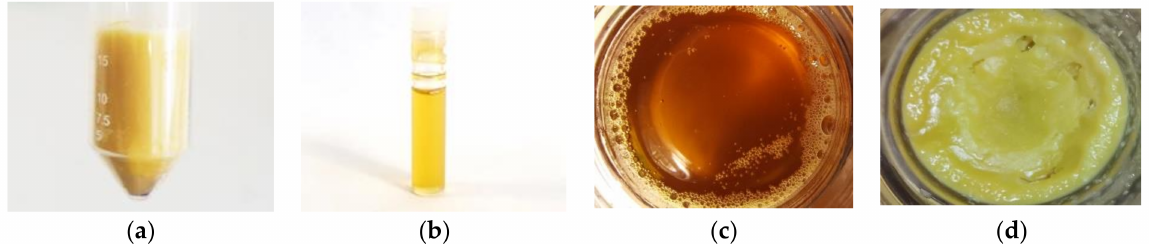
Figure 1. Fat of Black soldier fly larvae: ( a ) native; ( b ) after centrifugation; ( c ) liquid (t = 40 ◦ C); ( d ) solid (t = 20 ◦